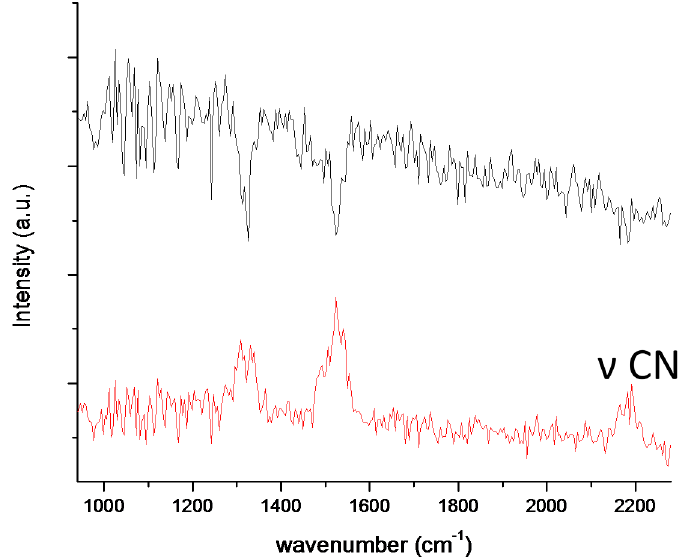
Figure 4. IRMPD action spectra of the anion C 4 H 3 N 4 − . The upper trace represents the trapped precursor ion m/z 117; and the lower trace represents all fragments of m/z 117 as a function of the IR radiation wavenumber. The CN stretching band is detected around 2180 cm − 1 .